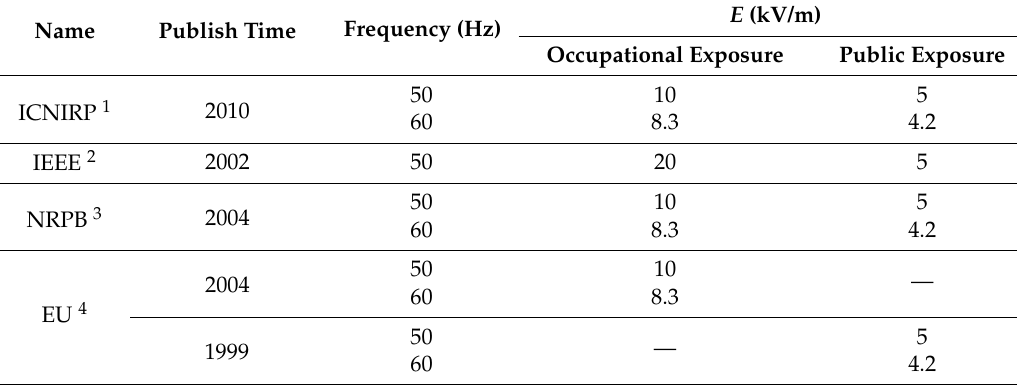
Table 1. Exposure limits regarding power-frequency electric fields developed by relevant institutions and international